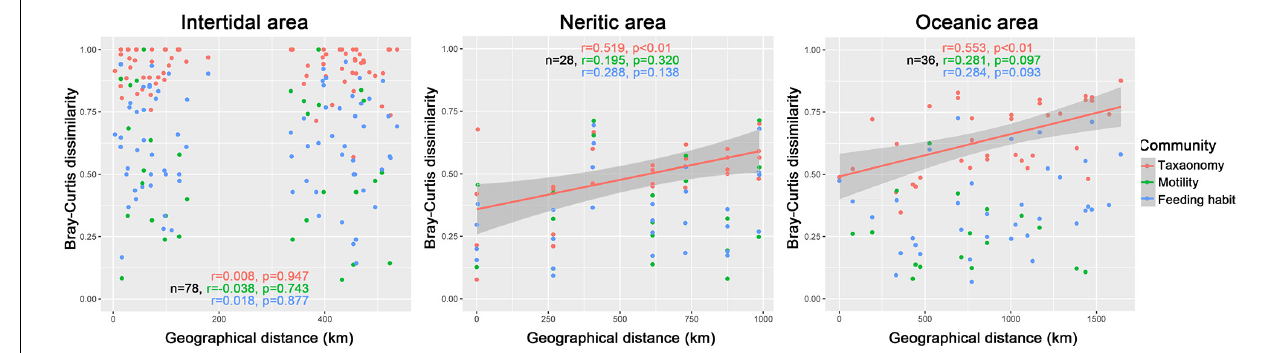
FIGURE 4 | Spearman’s rank correlations between the pairwise Bray–Curtis dissimilarity of communities and the geographical distance of samples in intertidal, neritic, and oceanic water. The n is the number of comparisons for samples, the r is the correlation coefficient for taxonomy (red text and symbols), motility (green text and symbols), and feeding (blue text and symbols) habits